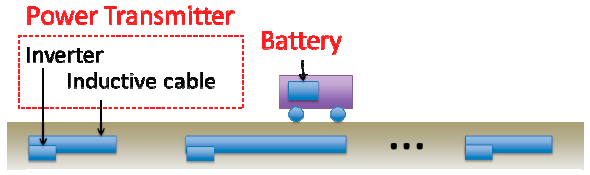
Figure 1. Dynamic wireless charging system.